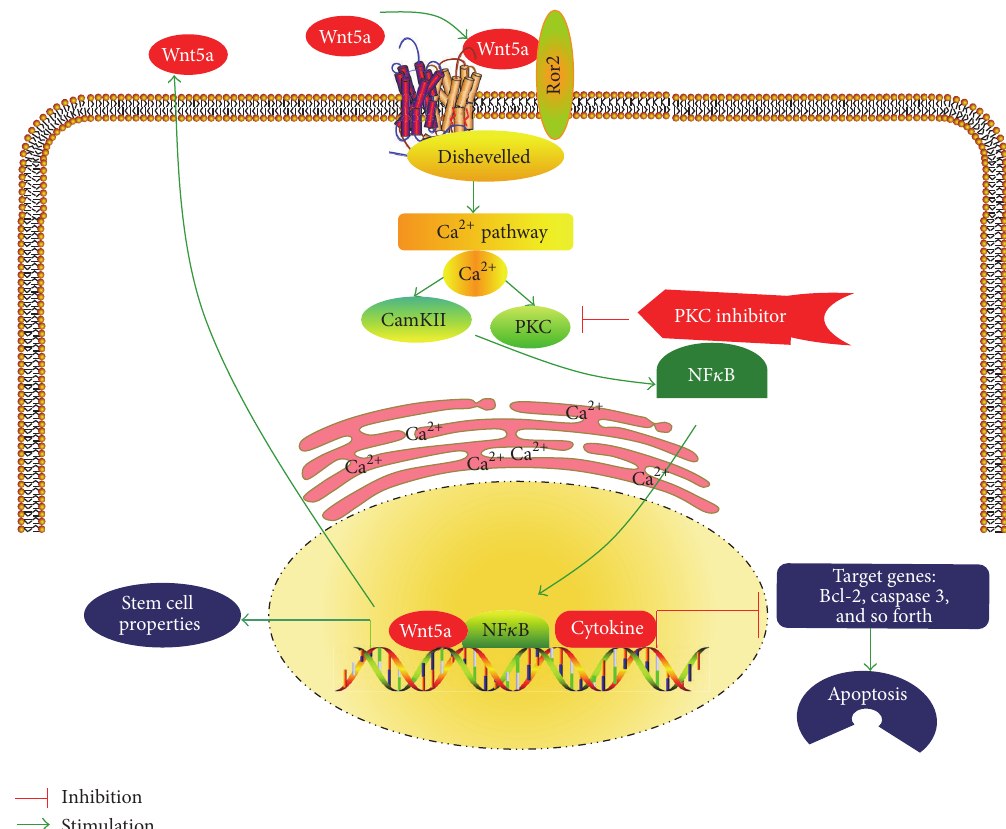
Figure 9: A schematic model to summarize Wnt5/PKC signaling pathway in lung cancer. Wnt5a activates PKC signaling and leads to endoplasmic reticulum (ER) release of Ca 2 +; PKC and CaMKII are activated, which in turn activate NF 𝜅 B. Subsequently, the activated NF 𝜅 B signaling promotes stem cell properties and inhibits apoptosis in lung cancer. CaMK: calcium/calmodulin kinase; FZD: Frizzled; PKC: protein kinase C; Ror: receptor tyrosine kinase-like orphan